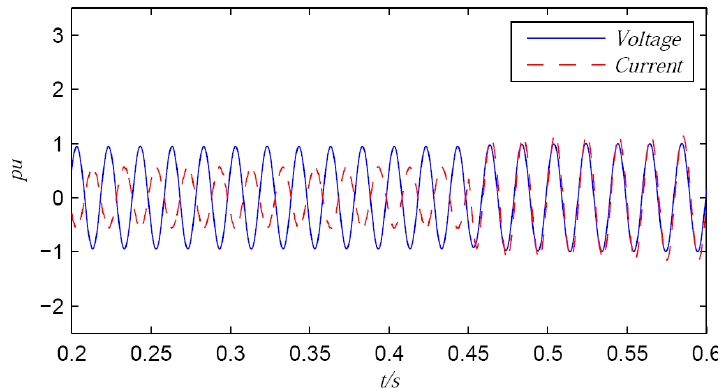
Figure 14. Single ‐ phase voltage and current output by synchronization of dq rotating coordinate.